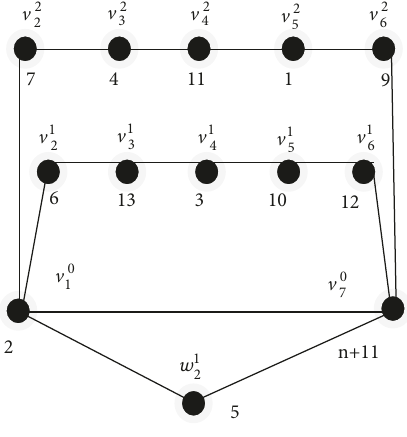
Figure 8: Bijective function ℎ 1 (𝑥) .